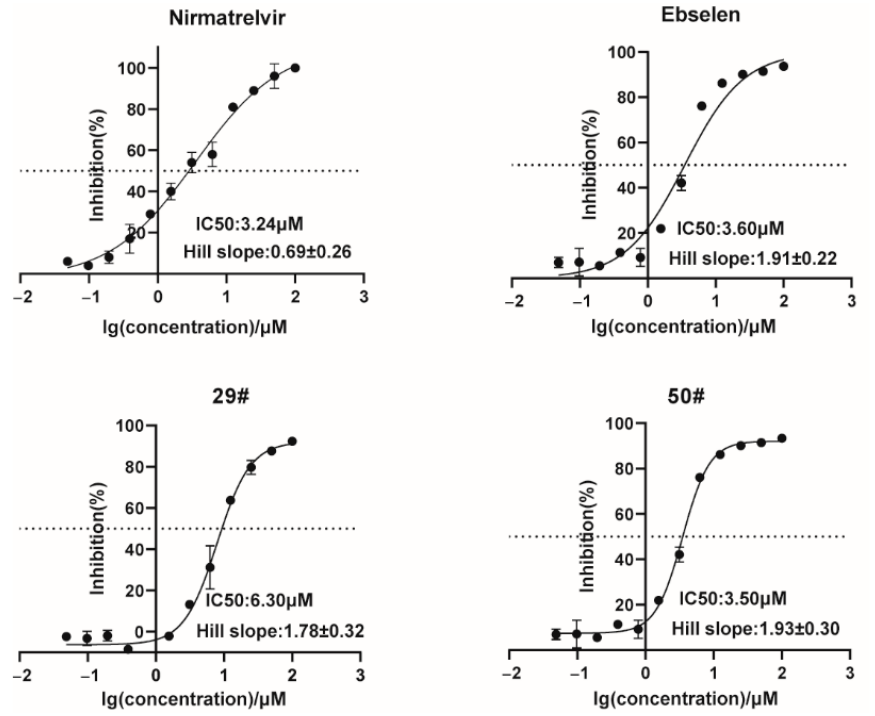
Figure 3. Dose-response inhibition curves of selected hits against the 3CL pro . The hits with different concentrations were pre-incubated with 100 nM of SARS-CoV-2 3CL pro for 30 min at 30 °C, and then a 10 µ M FRET substrate was added to the reaction mixture to initiate the reaction. The reaction was monitored for 2 h. The initial velocity was calculated by linear regression using the data points from the first 15 min of the reaction. The calculated initial velocity with each compound was normalized to the DMSO control. The results are an average ± standard deviation of three repeats.